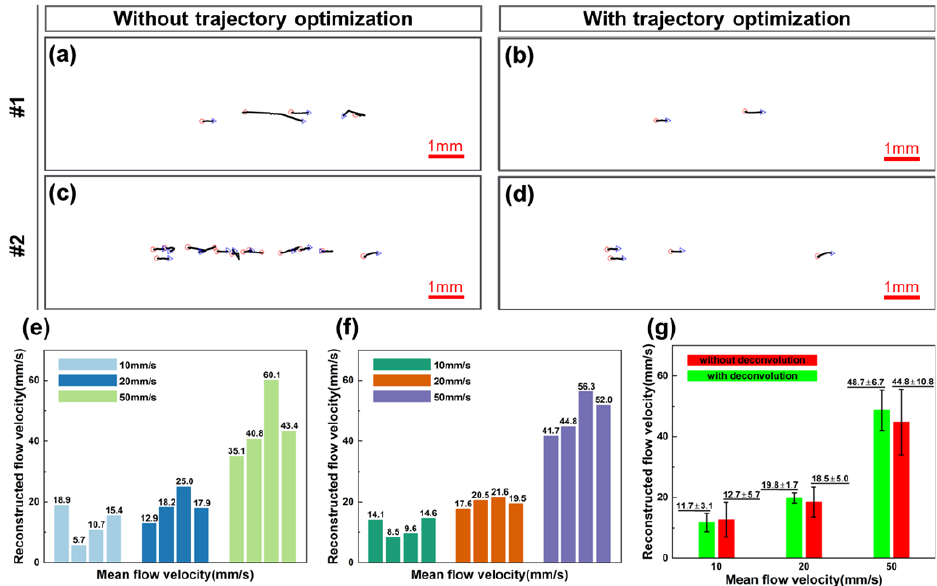
Figure 8. ( a – d ) Comparison of MB trajectories persistently tracked successfully for consecutive ten frames before and after optimization in flow phantom. ( e – g ) The bar plot of calculation results, mean and standard deviation under different test speeds before and after image deconvolution processing.